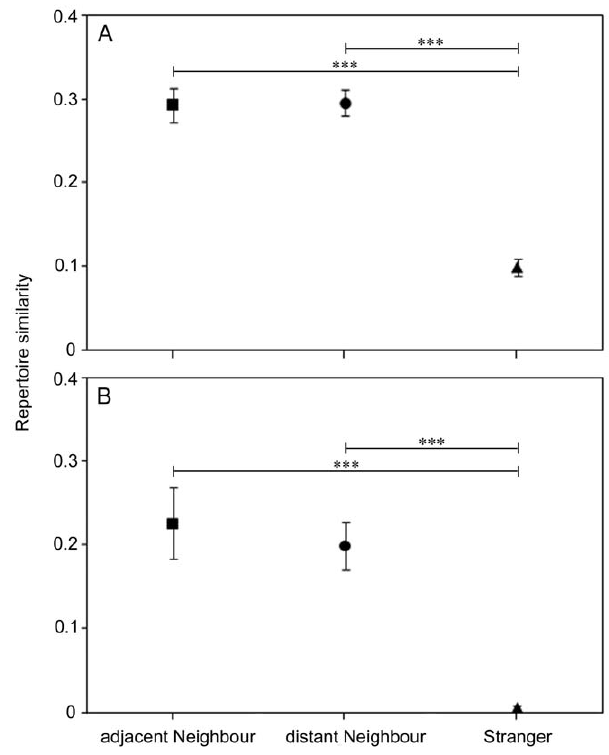
Figure 4. Syllable and sequence sharing. Mean 6 SE ( n= 7 pairs for each category) syllable repertoire sharing (A graph) and sequence of 3 to 10 syllables repertoire sharing (B graph) between adjacent neighbours (squares), distant neighbours (circles) and strangers (triangles). Adjacent and distant neighbours share a similar amount of syllables and sequences in their songs and more syllables and sequences than strangers (Exact paired permutation test using the Monte Carlo method, *** p ,